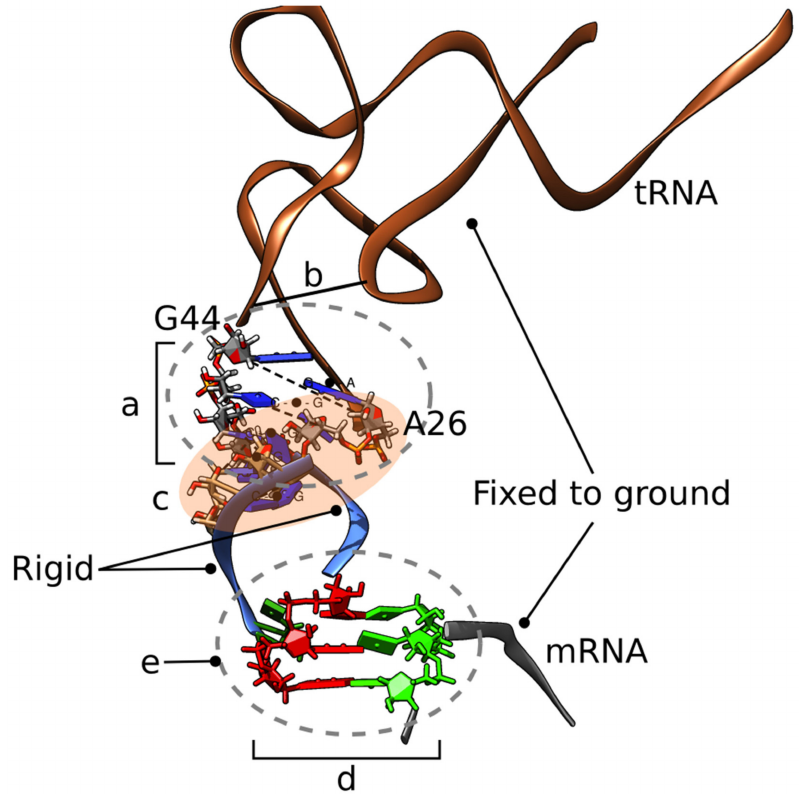
Figure 2. Structure, flexibility, and forces used to create the initial doublet-decoding models. ( a ) The tRNA is flexible around the hinge formed by residues 26, 27 and 43, 44. Physics is enabled for these residues. ( b ) Residue Y44 is constrained to residue 10. ( c ) Residues 26–30 and 44–40 form a nucleic acid duplex. Residues 25–28 have imposed helical stacking forces. ( d ) Anticodon residues 34–36 and codon residues 1 –3 are flexible. Base pairing is detailed below for each model. ( e ) Physics enabled for all residues within 1 nm of 35. With this multiscale setup, the Watson–Crick codon–anticodon base pairing forces (d) can simply be shifted from the initial triplet-triplet shown, to a doublet–doublet interaction to generate a clash-free doublet model. Not on figure: Springs enforce interactions with monitor residues 1492, 1493, and 530. It is essential to maintain the mRNA and anticodon stem-loop (ASL) in position. Protein S13 is flexible from residue 122 to 126 (C-ter) to remove clashes with the tRNA and position the residue 126 sidechain, which is absent from the crystal structure. A spring of 0.3 nm equilibrium length mimics the interaction of S13 residue R125 with a putative MG ion coordinated with 23S residue A1913 phosphate group. Collision-detecting spheres are placed on all heavy atoms within 1 nm of S13 residue 125 to prevent steric